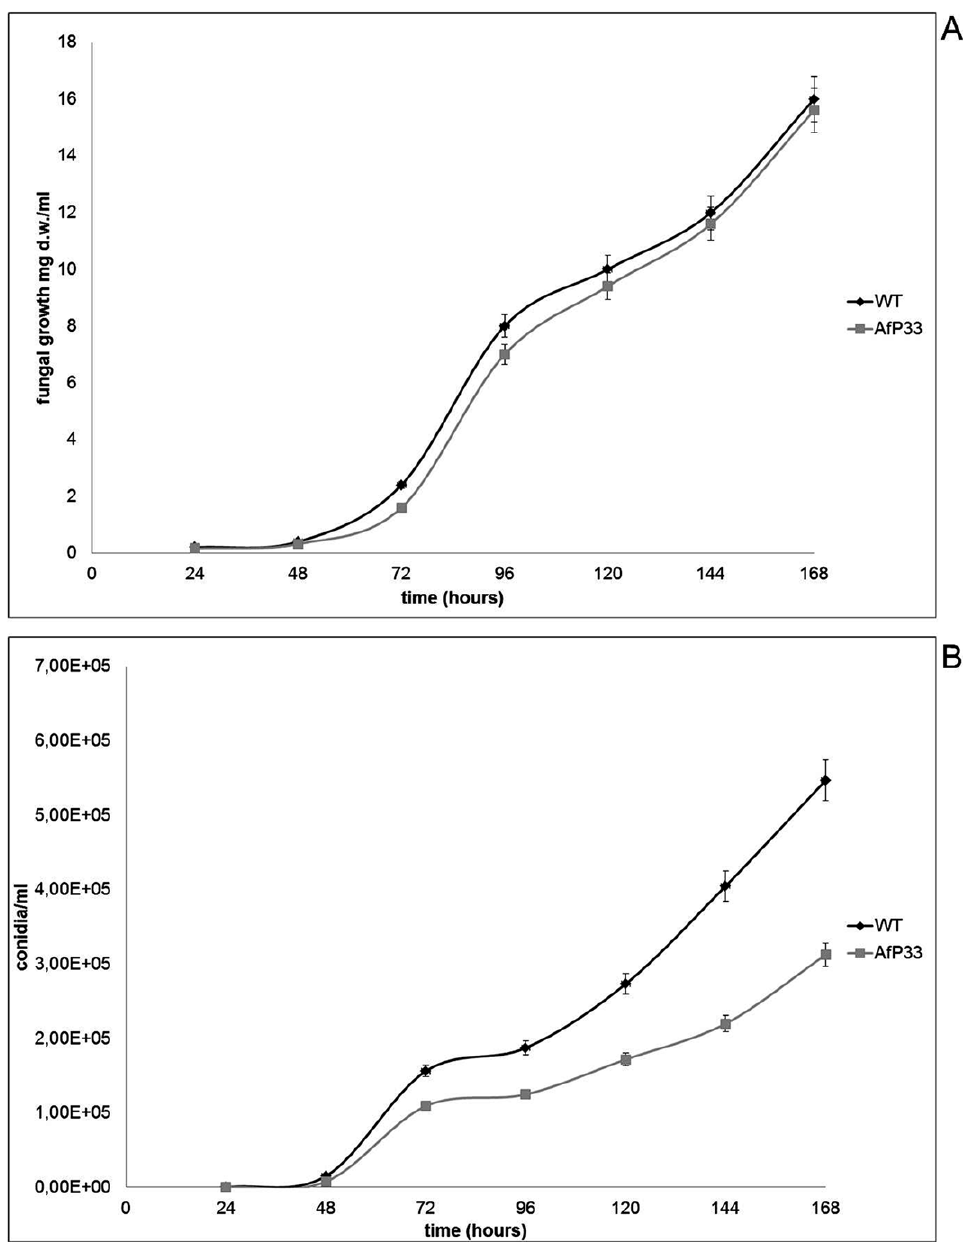
Figure 4. Fungal growth and conidiogenesis. A) Fungal growth (mg dry weight-d.w/mL). B) conidiogenesis (n. conidia/mL).